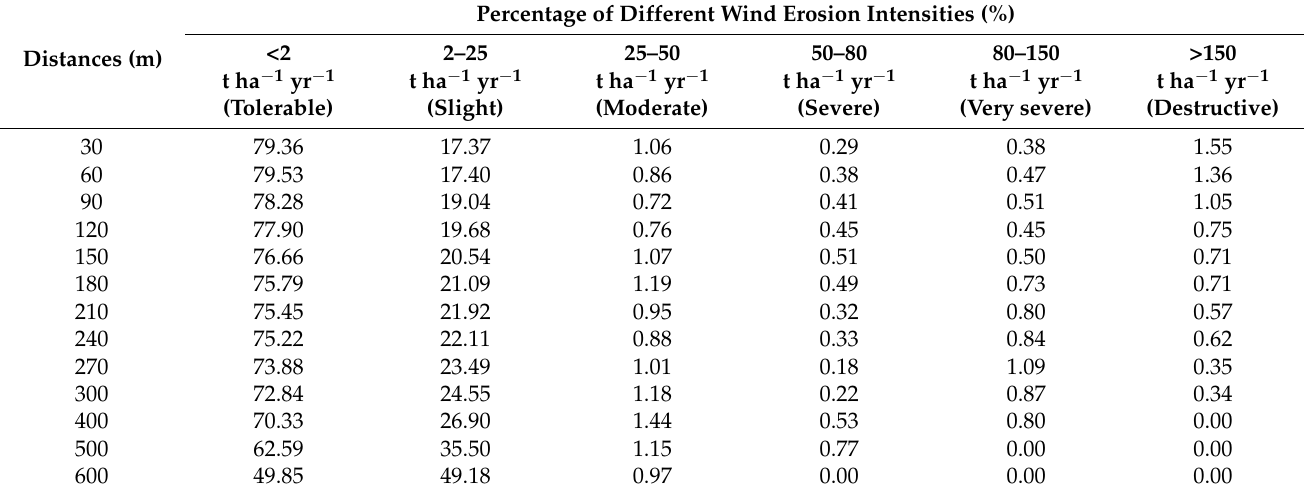
Table 2. Percentage of wind erosion intensities at different road buffer distances.